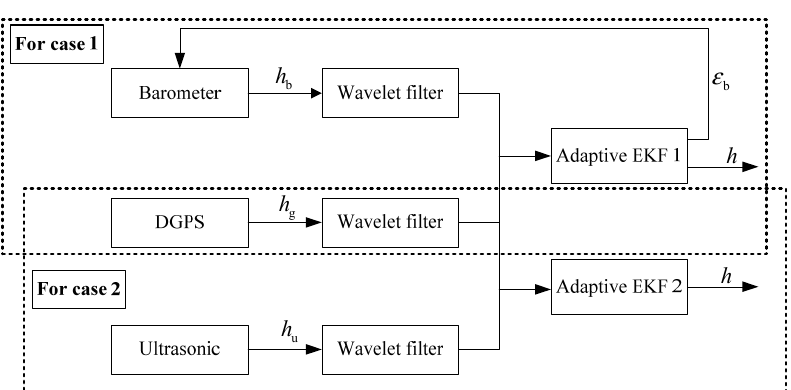
Figure 1. The scheme of altitude